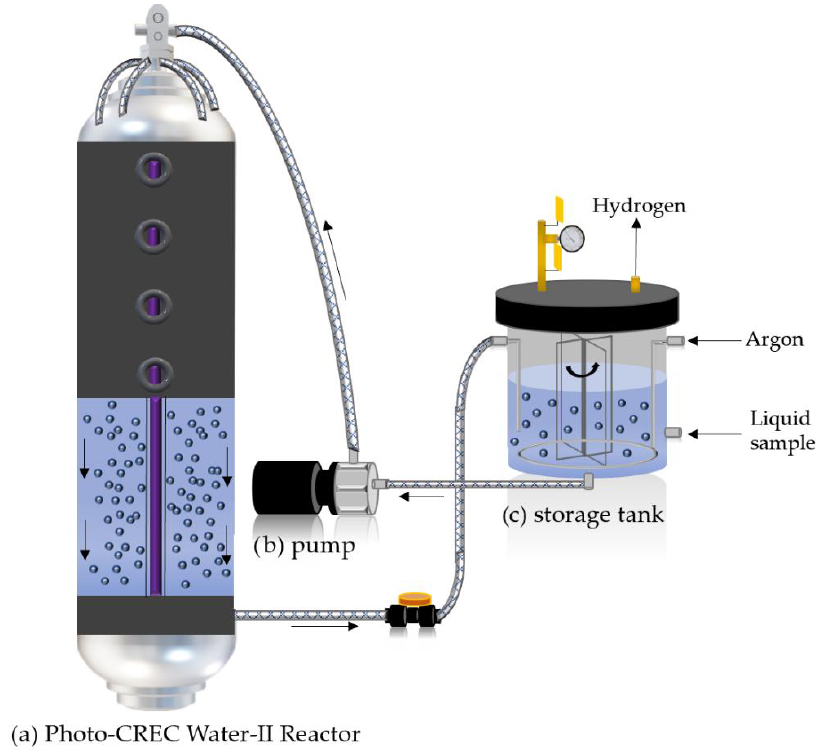
Figure 13. Schematics of the Photo-CREC Water-II Reactor. ( a ) Photo-CREC Water-II Reactor, ( b ) centrifugal pump, and ( c ) sealed storage tank.